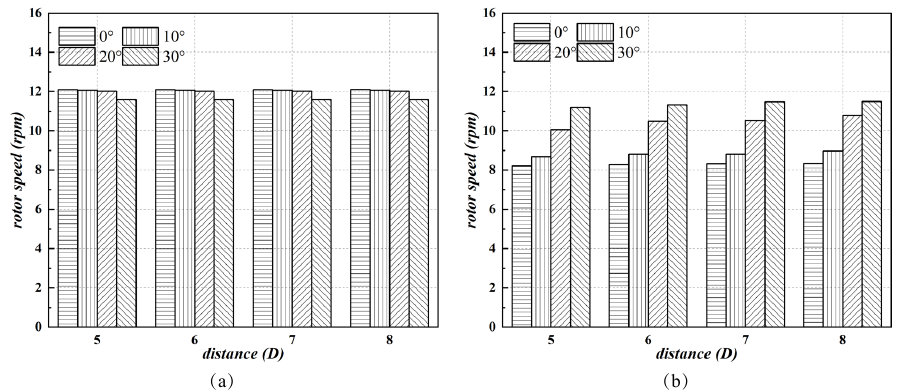
Figure 6. The average rotor speed of each turbine in different cases: ( a ) WT1; ( b )